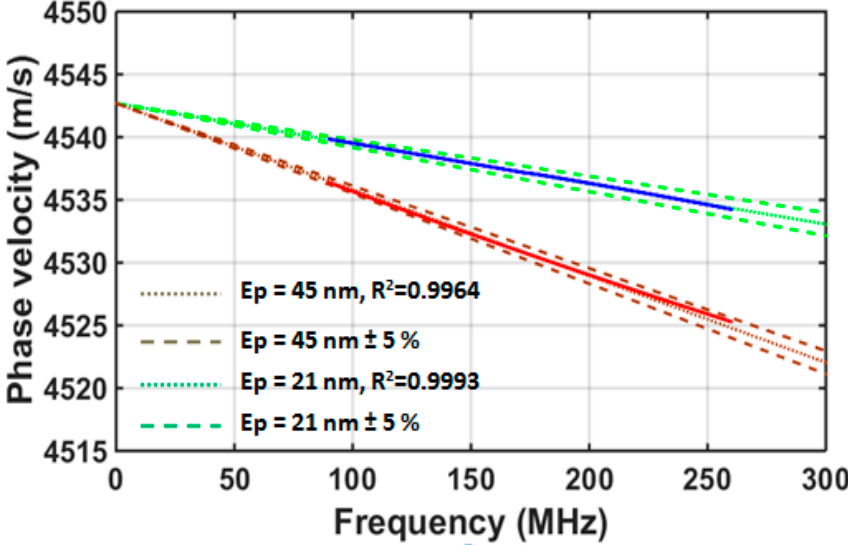
Figure 7. Theoretical (dotted lines) and experimental (solid lines) dispersion curves for 20 and 50 nm of titanium on silicon in the [110] direction, and the thickness E p inversion results. Dashed lines are theoretical curves corresponding to a ±5% thickness variation relative to the initial estimated value.